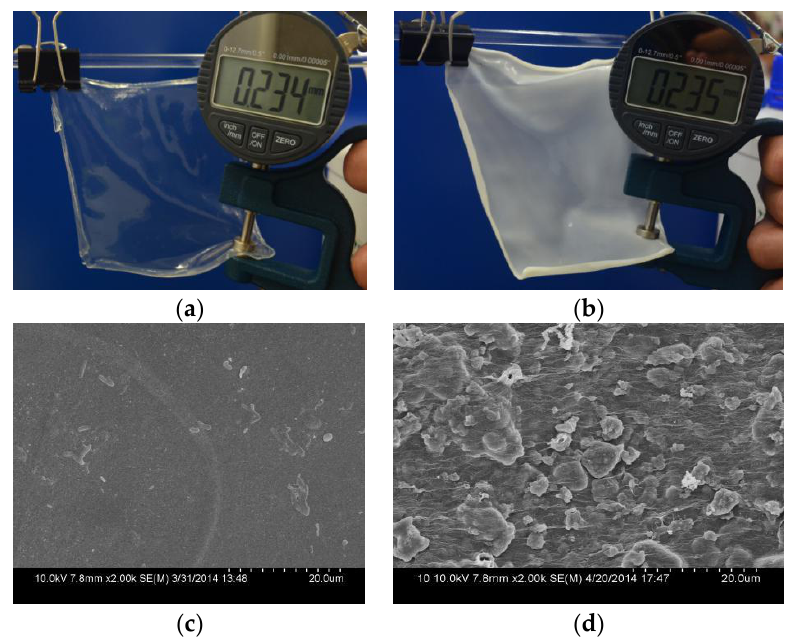
Figure 2. The surface digital photos and SEM images of CaAlg membrane ( a , b ) and kaolin/CaAlg composite membranes ( c , d ) (kaolin content: 70 wt.%; pore-forming agent urea: 2.5 wt.%).